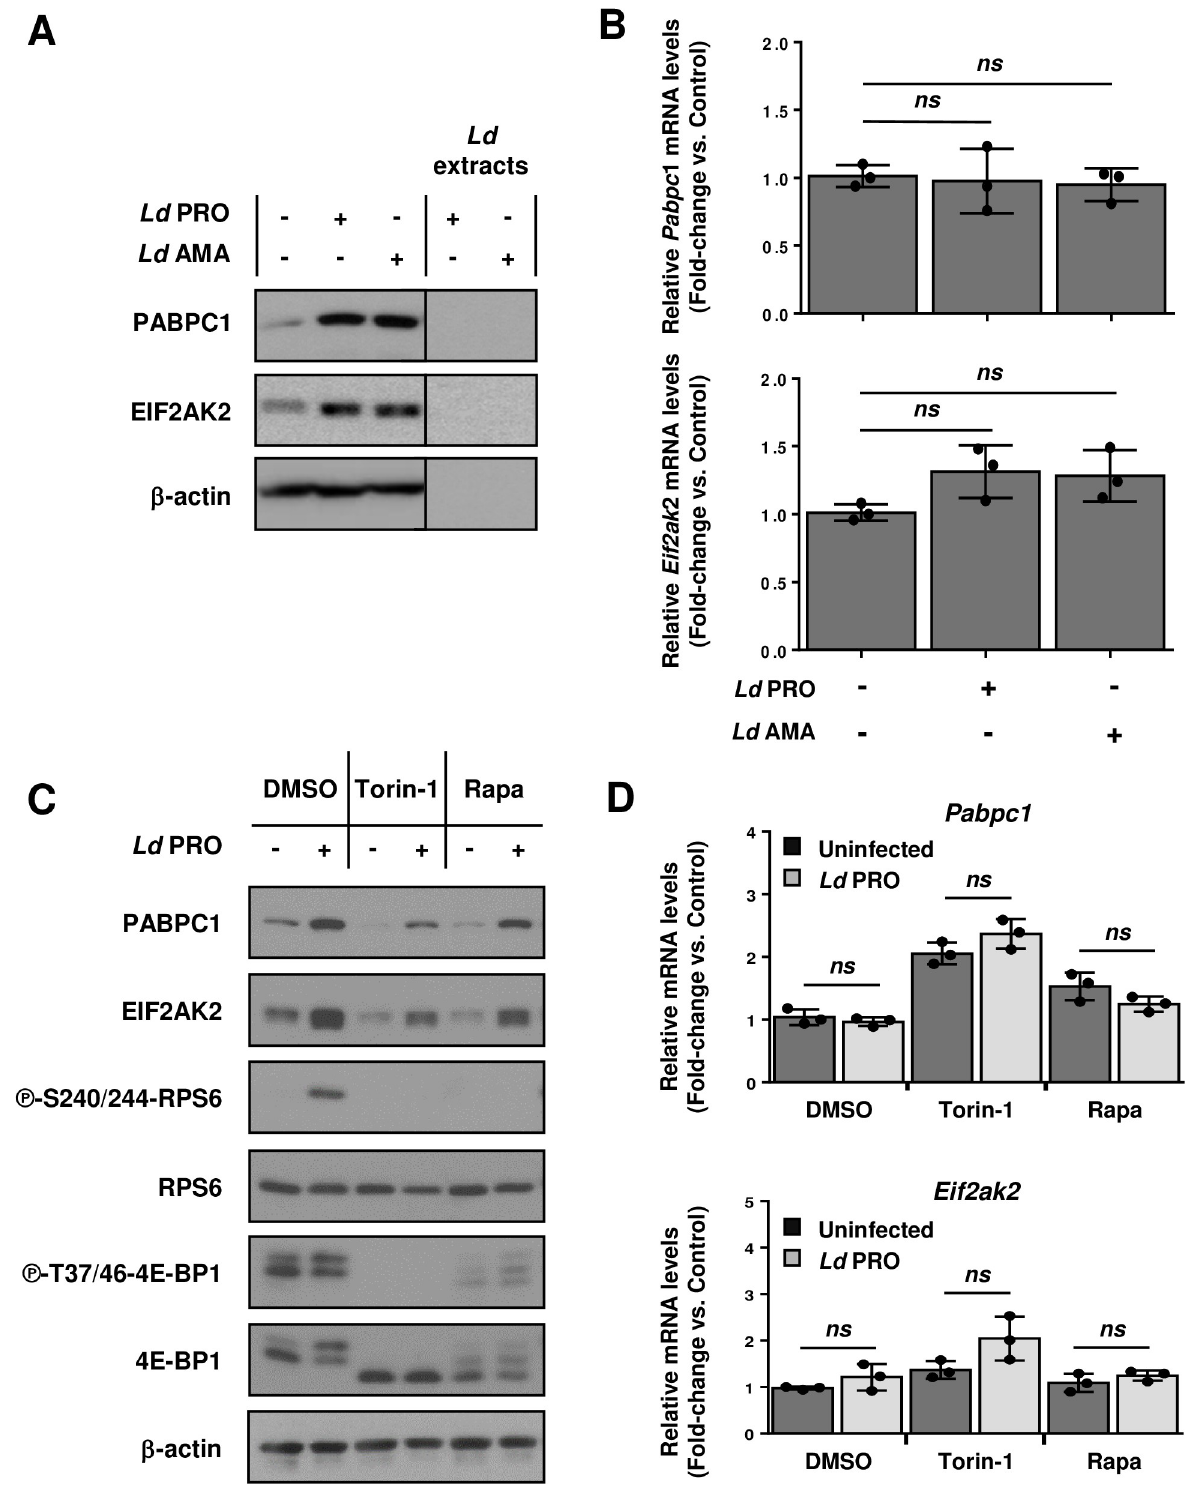
Fig 4. Upregulation of PABPC1 and EIF2AK2 in macrophages infected with L . donovani is mTOR-dependent. ( A - B ) BMDM cultures were inoculated with Ld AMA, Ld PRO or left uninfected for 6 h. ( C - D ) Cells were pre-treated with 200 nM of Torin-1, 20 nM rapamycin (Rapa) or DMSO for 2 hours before infection. ( A , C ) Total levels of PABPC1 and EIF2AK2 were monitored by Western blotting. ( C ) Phosphorylation status of mTOR downstream targets RPS6 and 4E-BP1. ( B , D ) Relative mRNA amounts of Pabpc1 and Eif2ak2 (normalized to Actb ) were measured